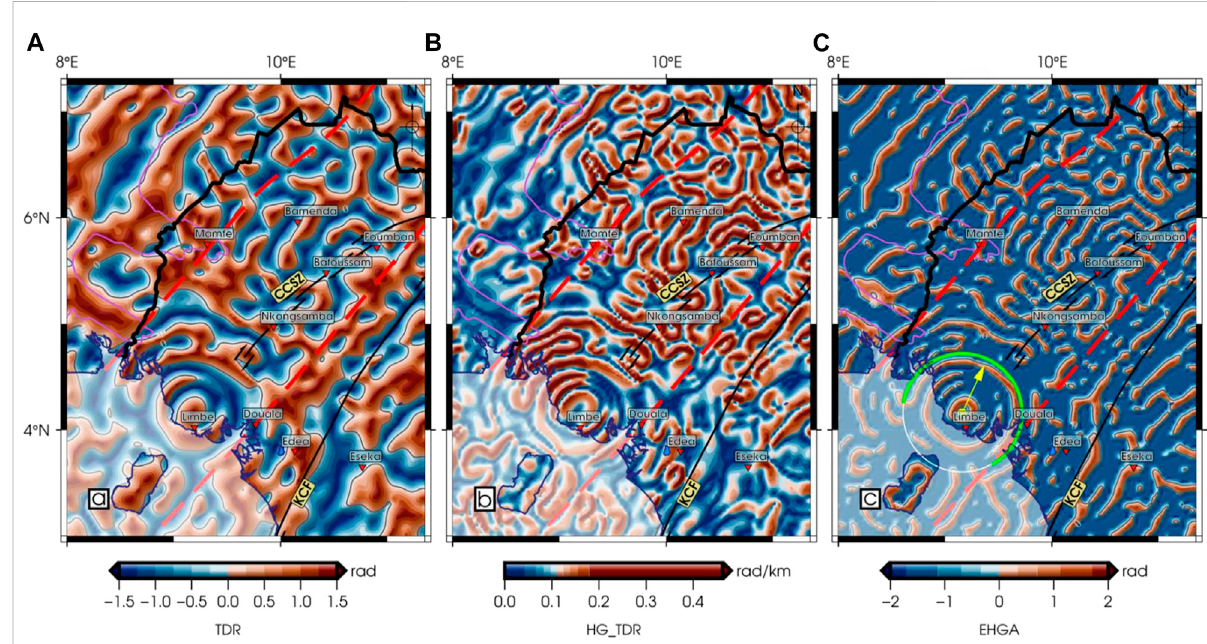
FIGURE 8 (A) Tiltderivative(TDR); (B) thehorizontalgradientofthetiltderivative(HG_TDR);and (C) theenhancedhorizontalgradientamplitude(EHGA)of the Bouguer residual map (black lines represent national boundaries). In green: the Fako and Tiko faults meet in a ring formation constituting the continental junction, spreading out to the Bakassi Peninsula and the Douala outlet. The yellow arrow denotes the average of the green